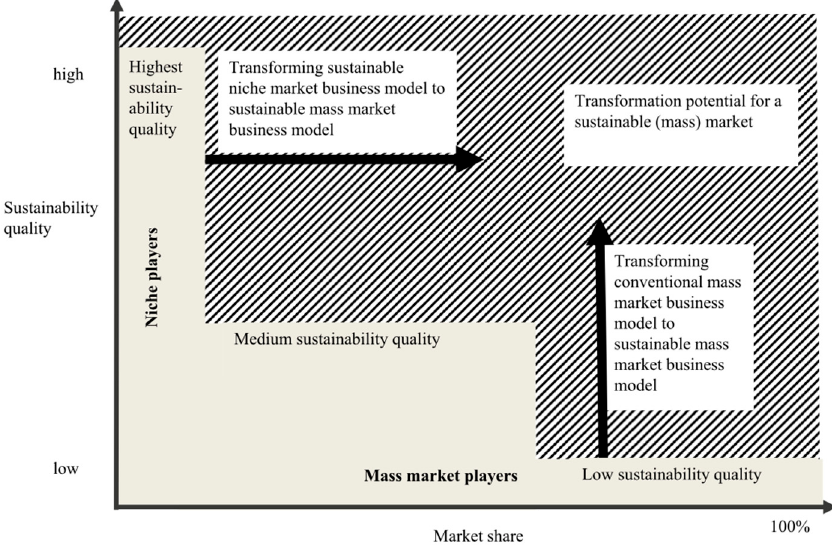
Figure 1. How sustainable entrepreneurship influences the sustainability transformation potential. [20].